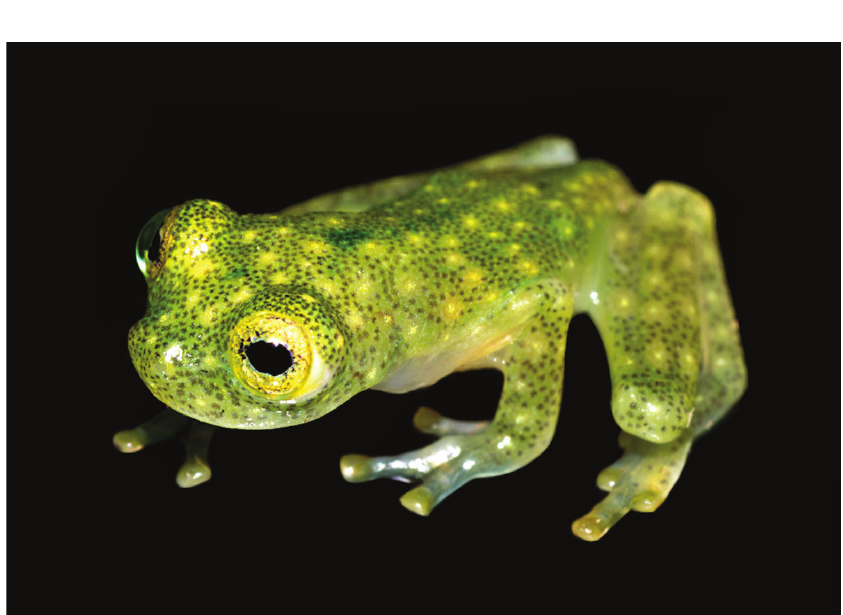
Figure 4. Juvenile of Hyalinobatrachium yaku in life, QCAZ